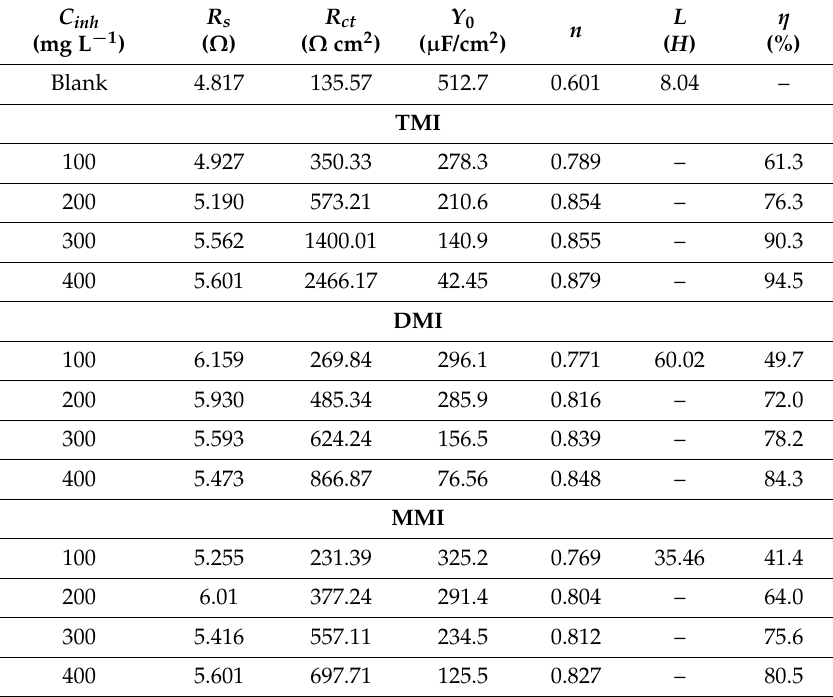
Table 3. Electrochemical impedance parameters in absence and presence of different concentrations of inhibitors at 308